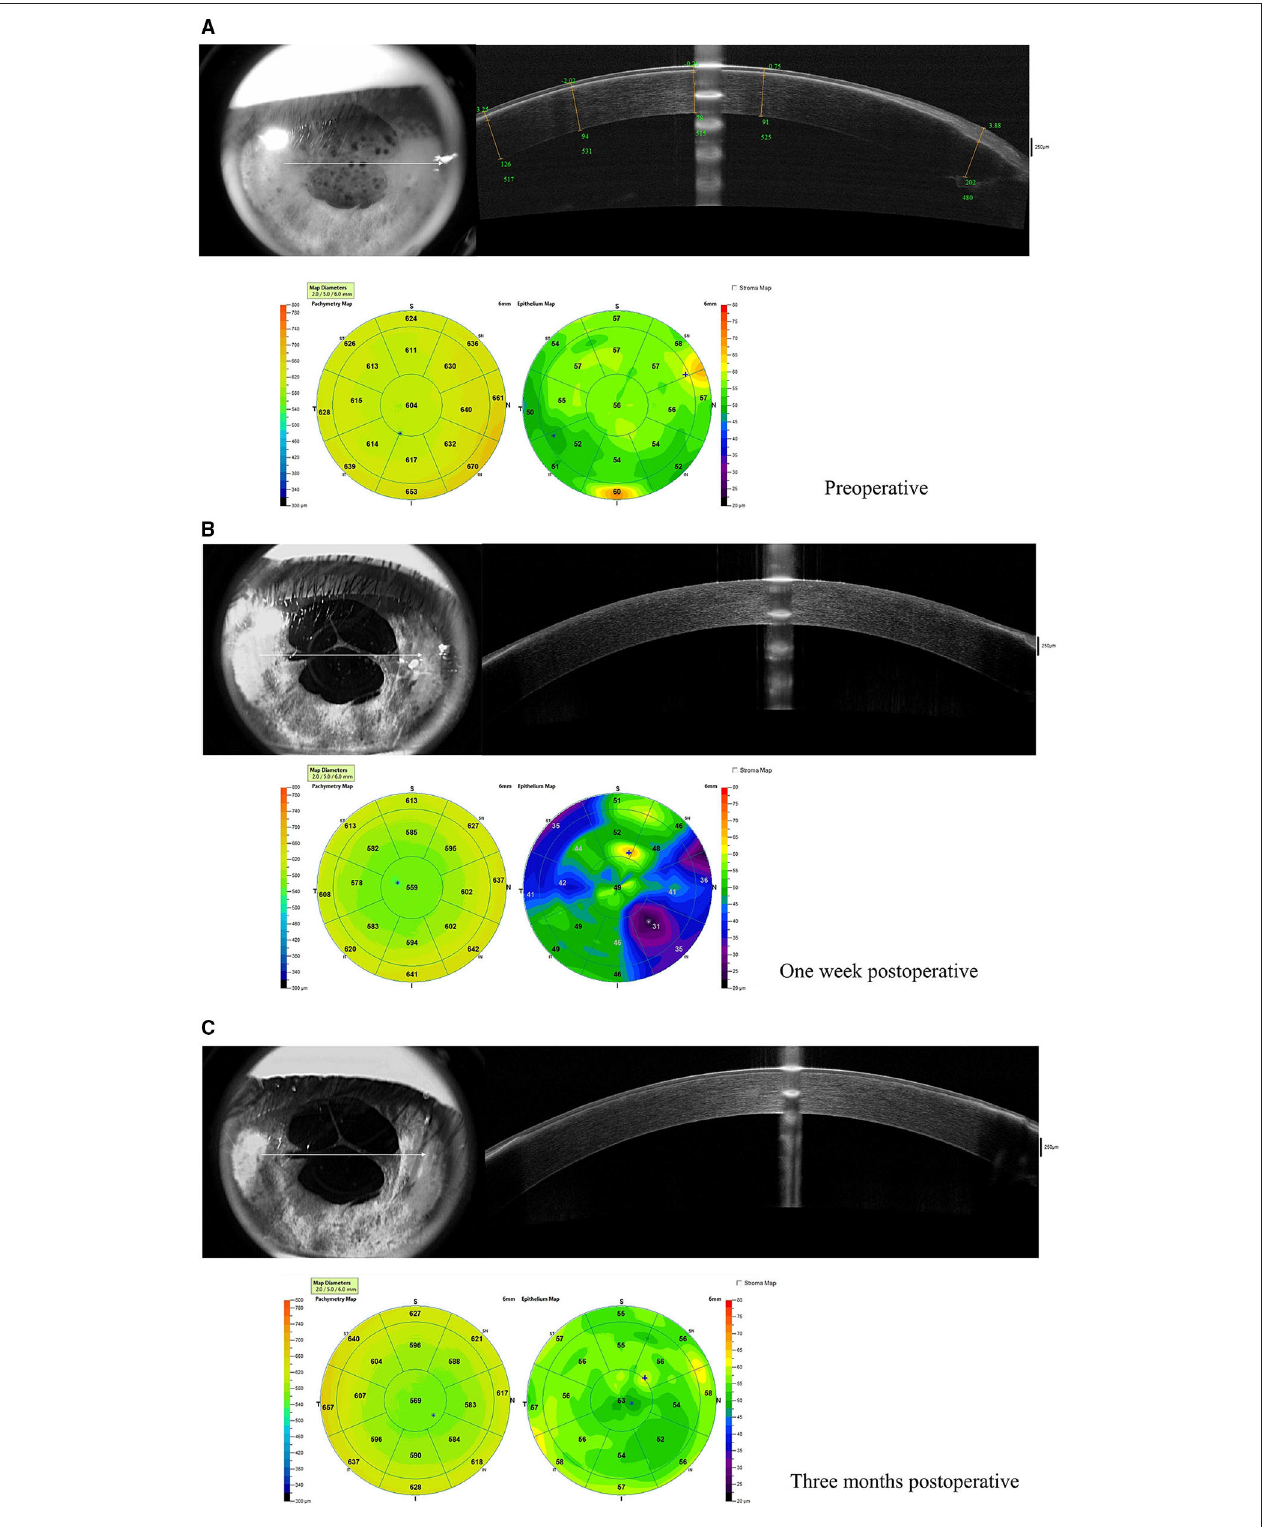
FIGURE 3 | Anterior segment optical coherence tomography (AS-OCT) before and after surgery. (A) Before surgery, a thin band of hyperreflectivity was along with Bowman’s layer. The upper right panels show the five segments (yellow lines) on the horizontal meridian. The green numbers represent the distance from the corneal vertex, the depth of the band, and the corneal thickness at the specific site, respectively; (B) one week and (C) three months after surgery, the band of hyperreflectivity disappeared.